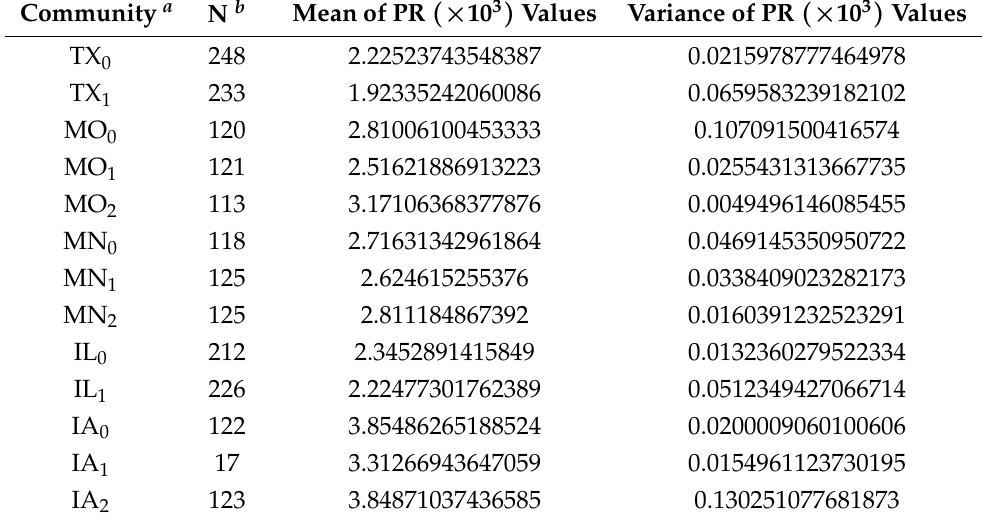
Table 1. Statistical analysis of the PR values of nodes in each community shown in Figure